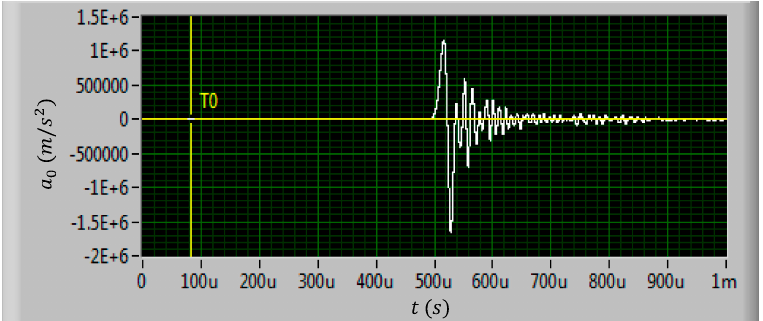
Figure 12. The measured 100,000 g shock load waveform.